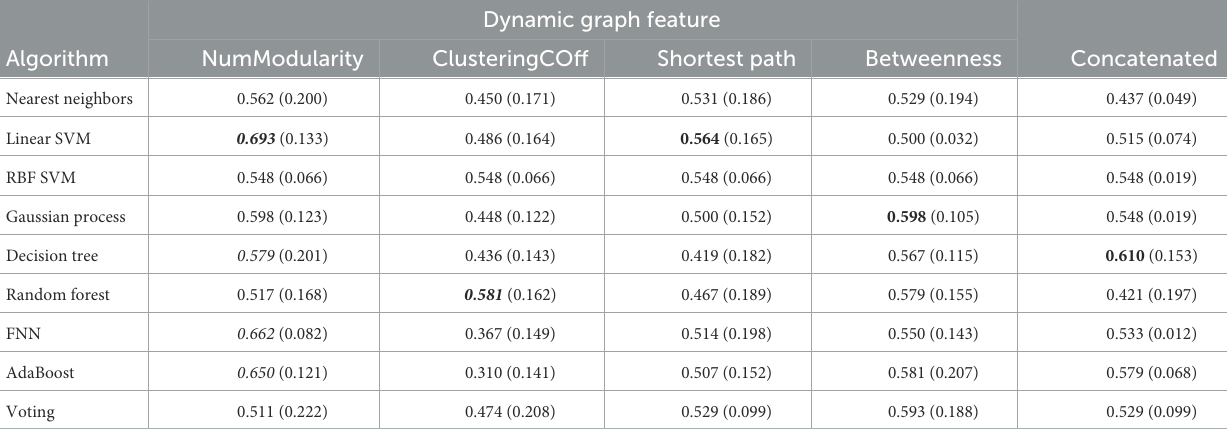
TABLE 6 The prediction accuracy of multiple machine learning algorithms with dynamic state features